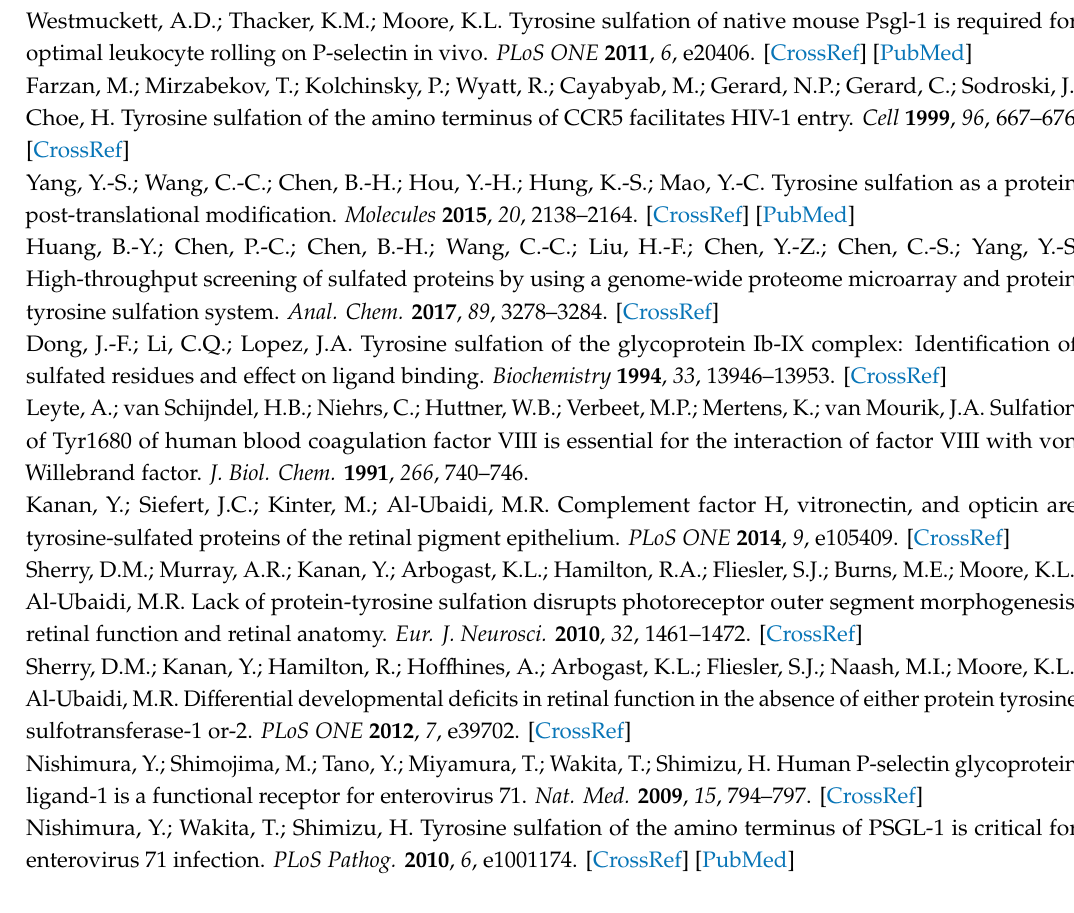
Figure S1: Electrical characteristics of the poly-Si NWFET, Figure S2: Eight consecutive measurements of I D -V G of the device, Figure S3: Electrical responses of the functionalized pSNWFET to PSGL-1 sulfation, Figure S4: Real-time response of the pSNWFET following di ff erent surface modifications, Figure S5: pH profile of the PSGL-1 modified surface, Table S1: Element contents on the modified